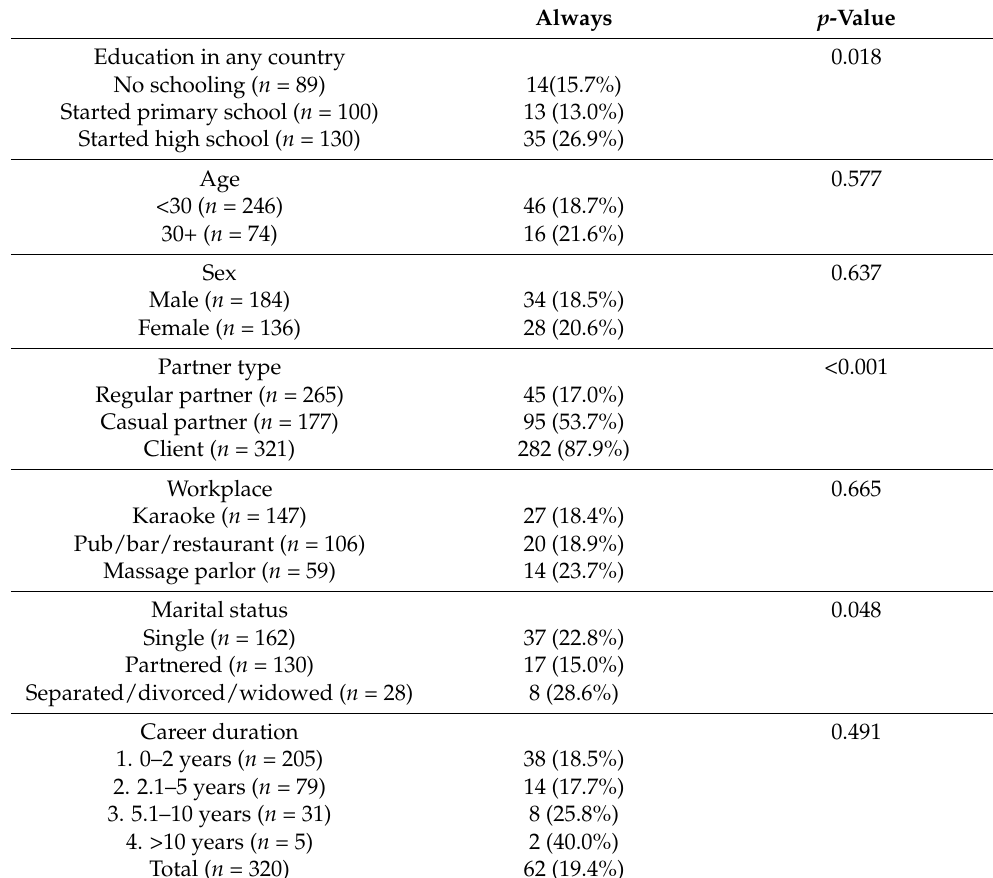
Table 2. Frequencyofcondomuseinthepastmonthbyeducation, age, sex, andworkplace.